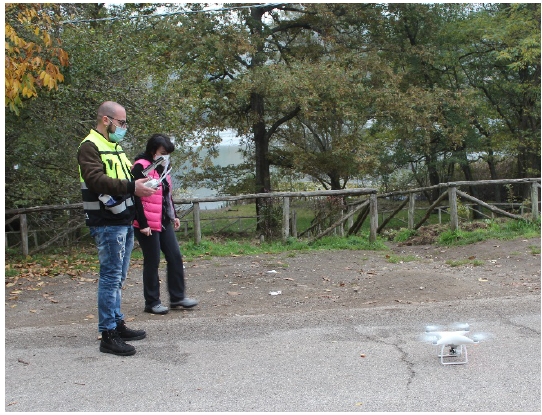
Figure 2. Dji Phantom 4 used for surveys .